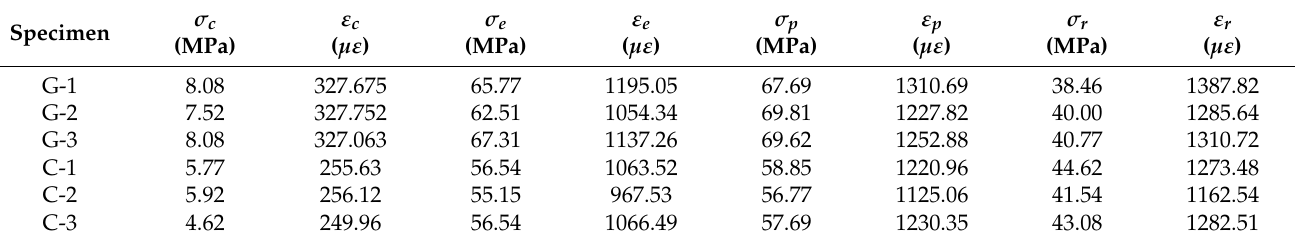
Table 2. Strain value and stress at each